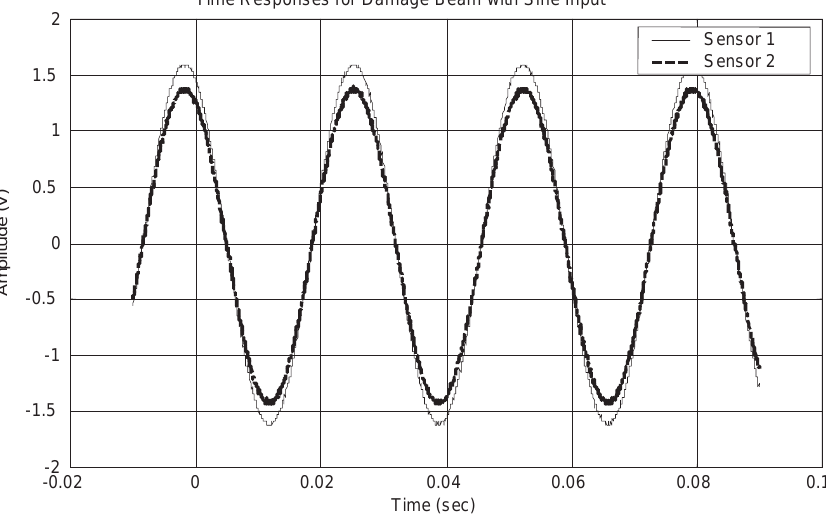
Fig. 12. Time responses of sensors S1 and S2 on the damage beam for the sinusoidal input.